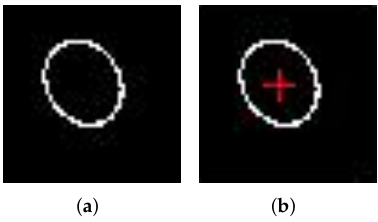
Figure 8. Subpixel center coordinate extraction. ( a ) The circular edge, ( b ) Circle extraction.